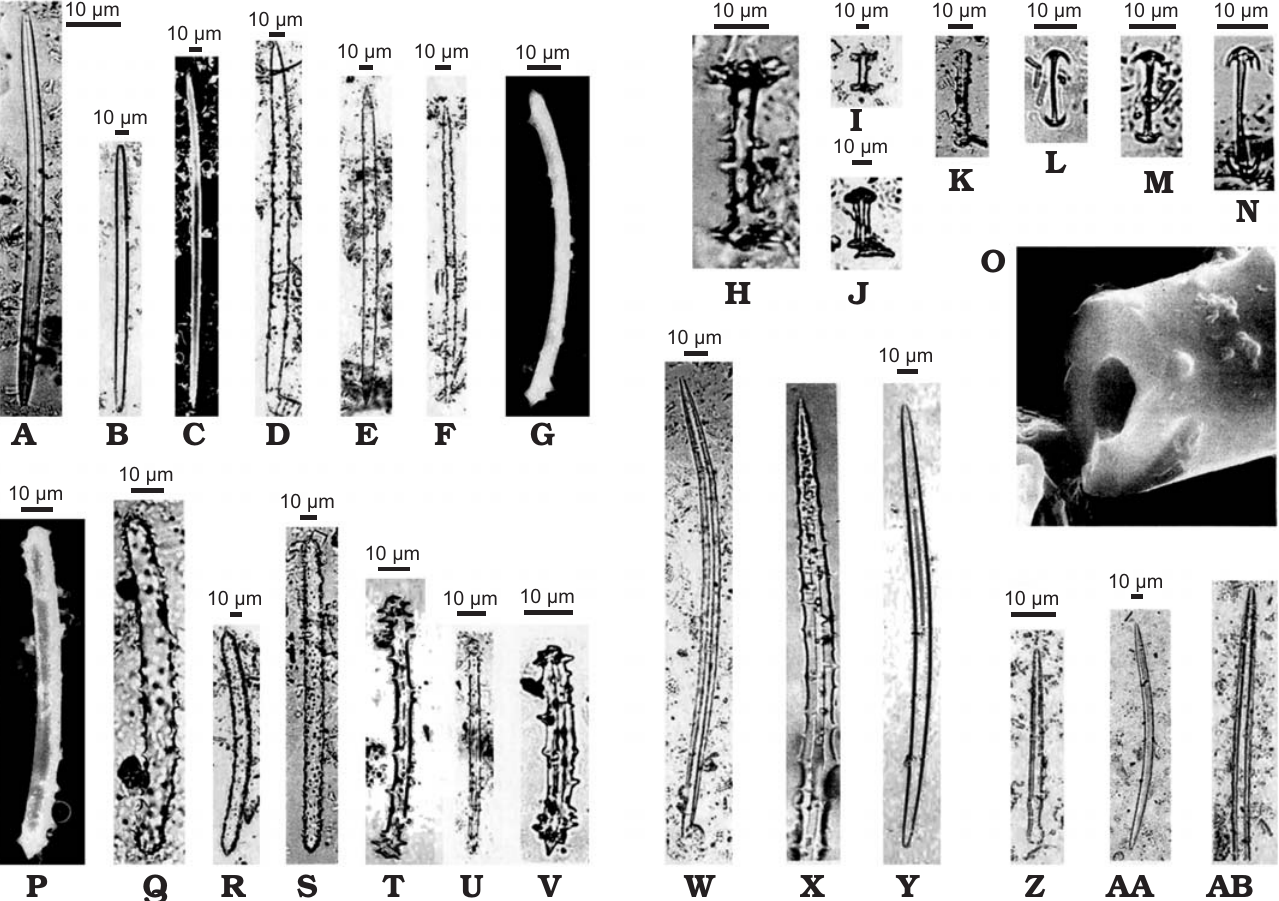
Fig. 22. Spicular remains of Spongillidae. Miocene, Lacustrine deposit at Oviatt Creek, northern Idaho, USA. Megascleres ( A – F , S , W – AB ), microscleres ( L – N ), and gemmuloscleres ( G – K , P – V ), ascribed originally to several genera: Anheteromeyenia , Corvospongilla , Eunapius , Radiospongilla , Spongilla , Trochospongilla ; X, originally enlarged × 1200, AB, originally enlarged × 700. O . Axial canal of a broken spicule, originally enlarged × 5300. G, O, P, SEM images. Modified from Williams